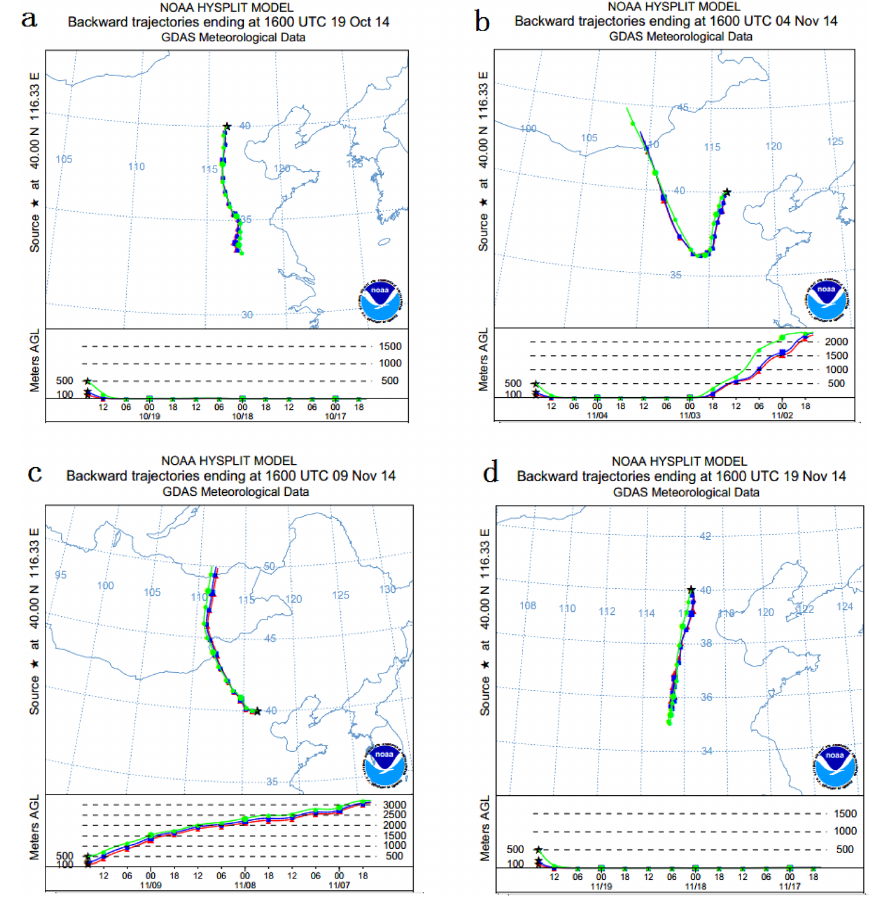
Figure 4. Three-day backward trajectories ending at 12:00 a.m. (16:00UTC) 19 October, 4, 9, and 19 November